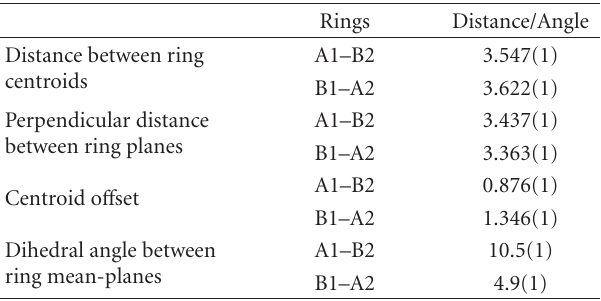
Table 3: Geometrical details ( ˚A, ◦ ) of the intramolecular π - π interactions between L A and L B ligands for complex 1 · 2MeOH.